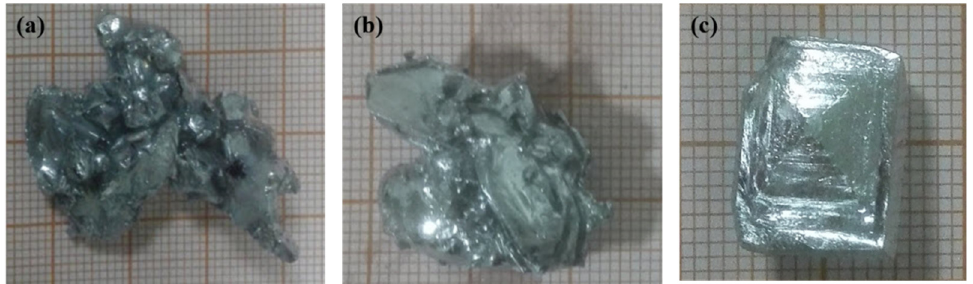
Figure 3. Crystalline morphology of liquid gallium after adding crystal seeds for 15 min at different temperatures of cooling water (( a ) 288 K, ( b ) 290 K, and ( c ) 293 K).